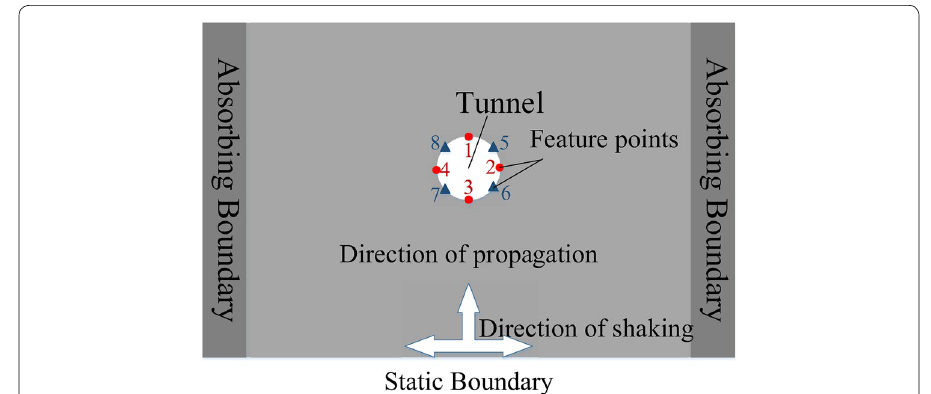
Fig. 3 Schematic diagram of numerical model (Points 1–8 are feature points)